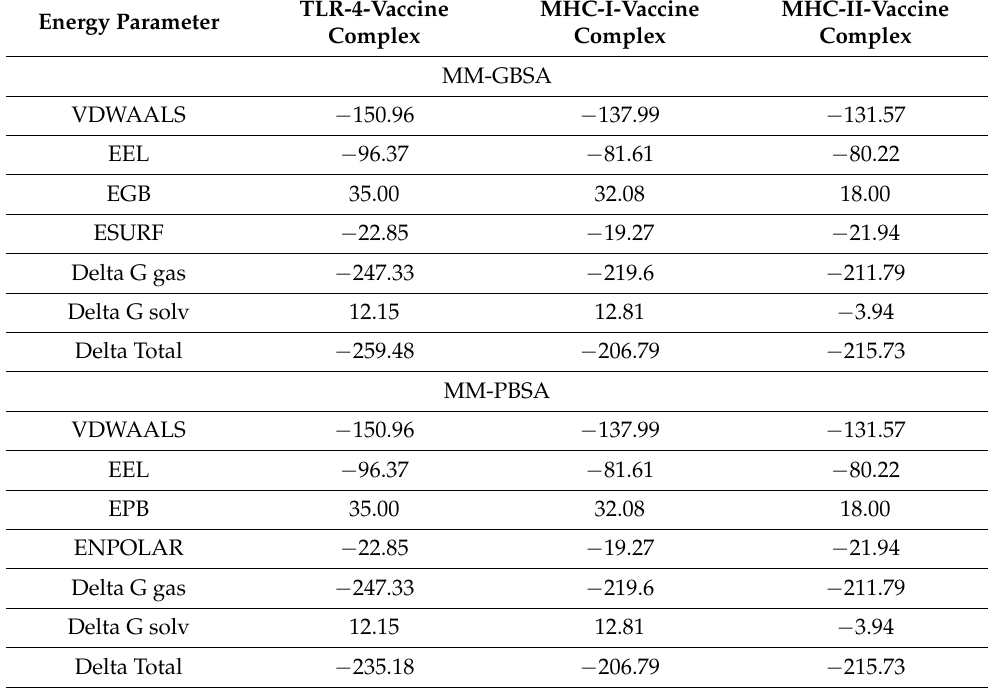
Table 8. Binding free energies calculation. The units are kcal/mol. Energy